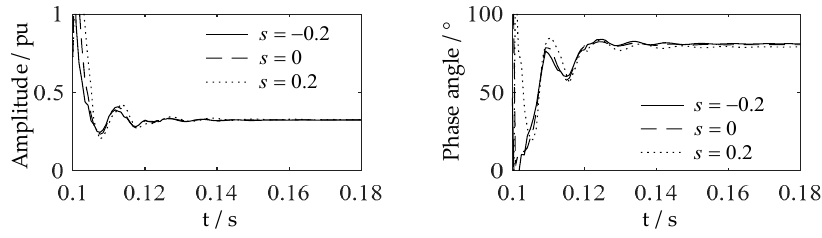
Figure 16. Characteristic simulation results of Z ∗ w − in Case 2.